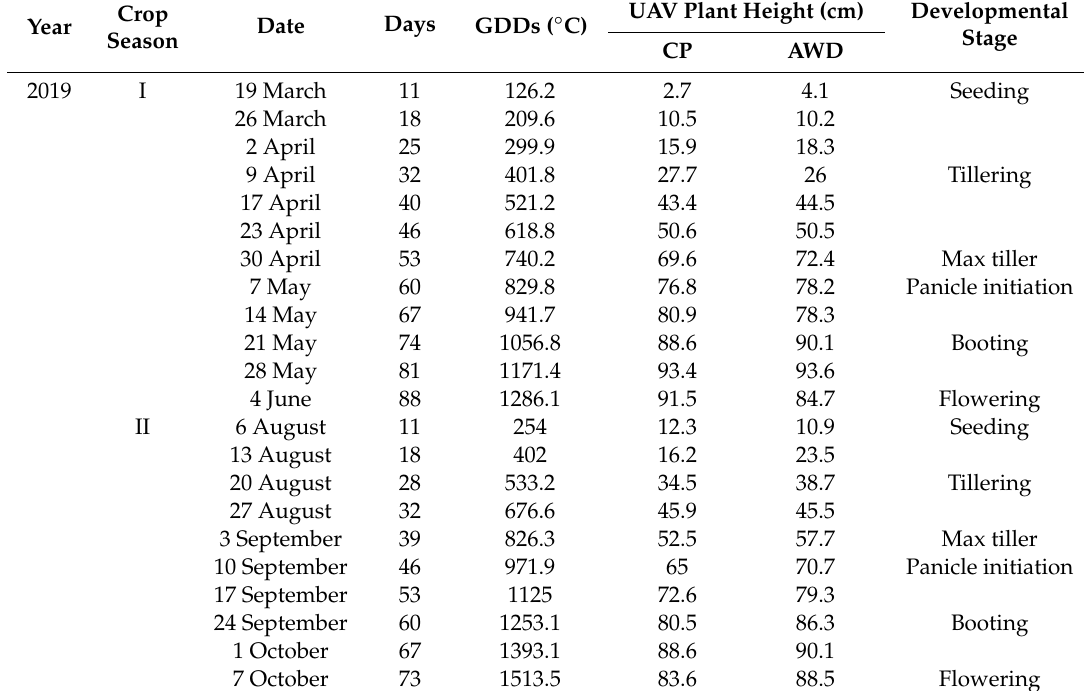
Table 3. The growing degree days (GDDs) and plant height of TNG71 rice variety planted under di ff erent water